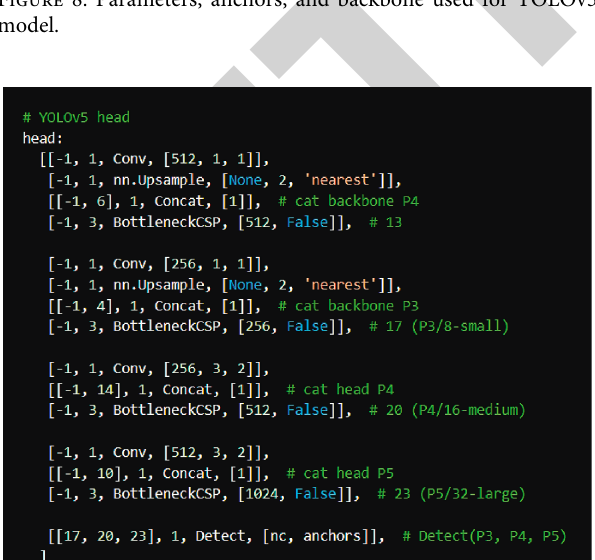
Figure 9: Displaying the information of the head of the YOLOv5 architecture used.